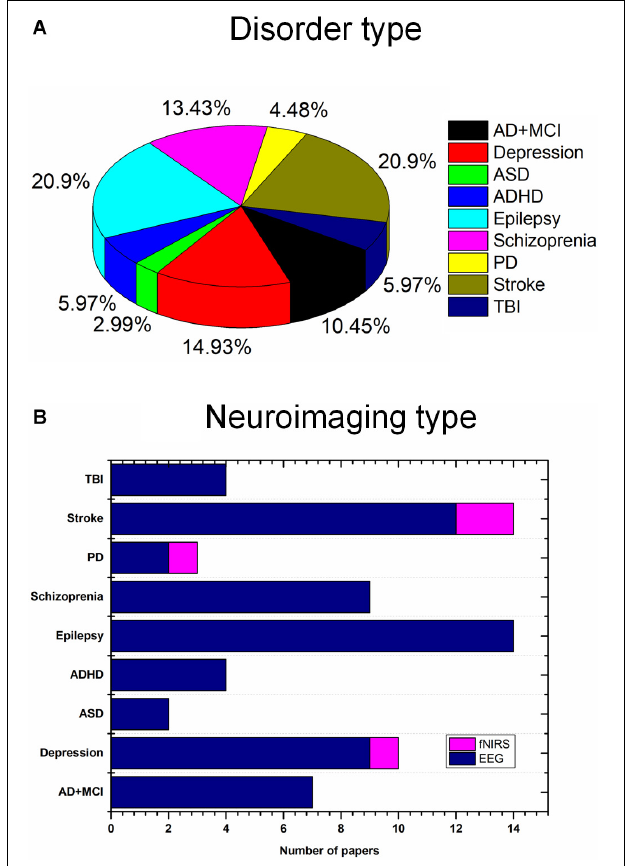
FIGURE 4 | Brain disorders and imaging techniques: (A) Nine brain disorders, (B) number of EEG/fNIRS papers per brain